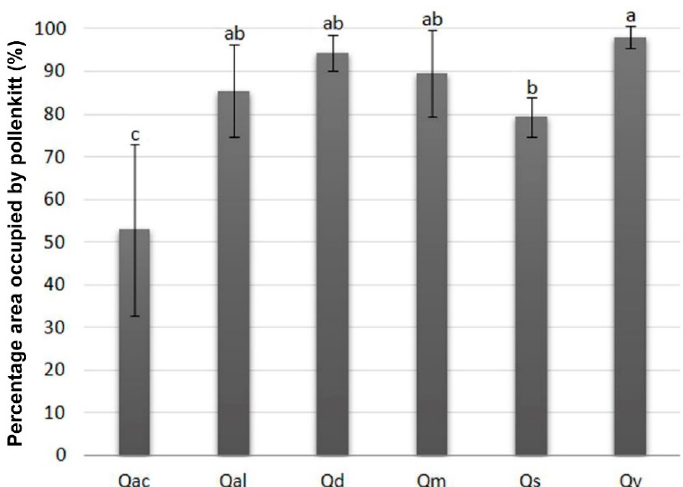
Figure 7. Percentage of occupied area by pollenkitt, the pollen coat covering the outer layer of pollen grains. Abbreviations: Qac, Q. acutissima ; Qal, Q. aliena ; Qd, Q. dentata ; Qm, Q. mongolica ; Qs, Q. serrata ; Qv, Q. variabilis . Different letters above bars along the x -axis denote statistically significant differences among Quercus species at p < 0.05.